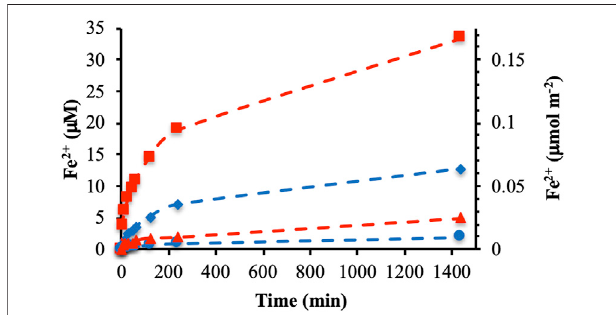
FIGURE 1 | Fe 2+ concentrations in solution from reductive dissolution of ferrihydrite by DOM ini-EtOAc ( ◆ , blue), DOM mod-EtOAc ( ■ , red), DOM ini-H2O ( blue) and DOM mod-H2O ( ▲ , red). All experiments were carried out at 12 µmol TOC m − 2 and pH 4.0 in 0.1 M NaCl. The data points represent the average of triplicate experiments, and the standard deviations in Fe 2+ concentrations are smaller than the size of the